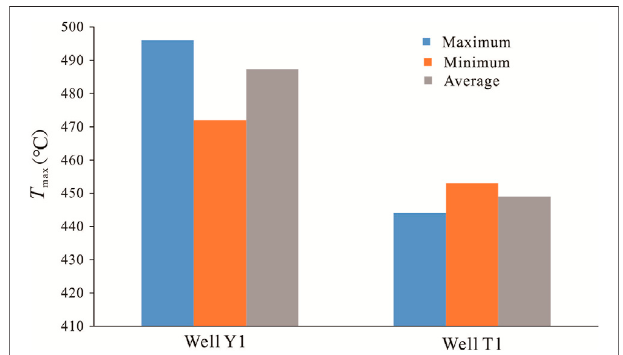
FIGURE 6 | Comparison of T max for the J 1 da shale sample in Yuanba and Puguang.